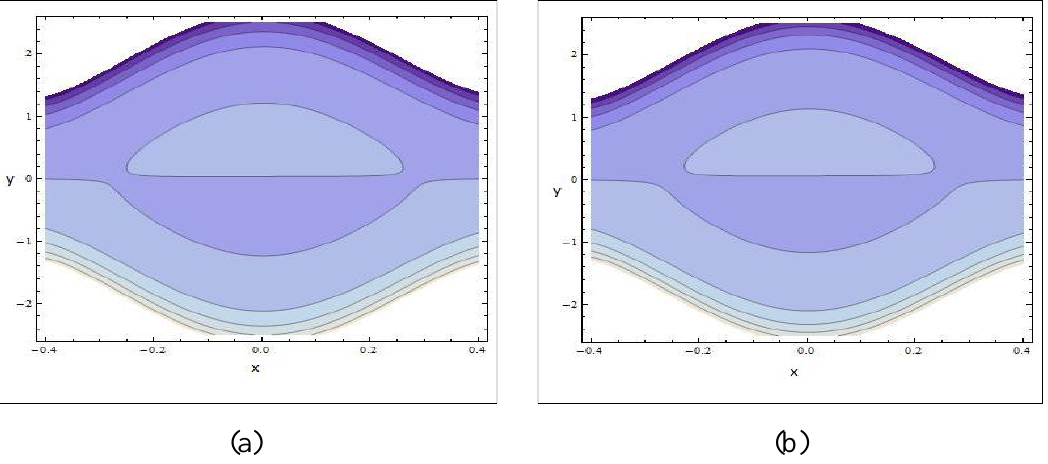
π = 0.009, η = 0.001, , M = 2.2, ϕ = 0.01, η 5 1 2